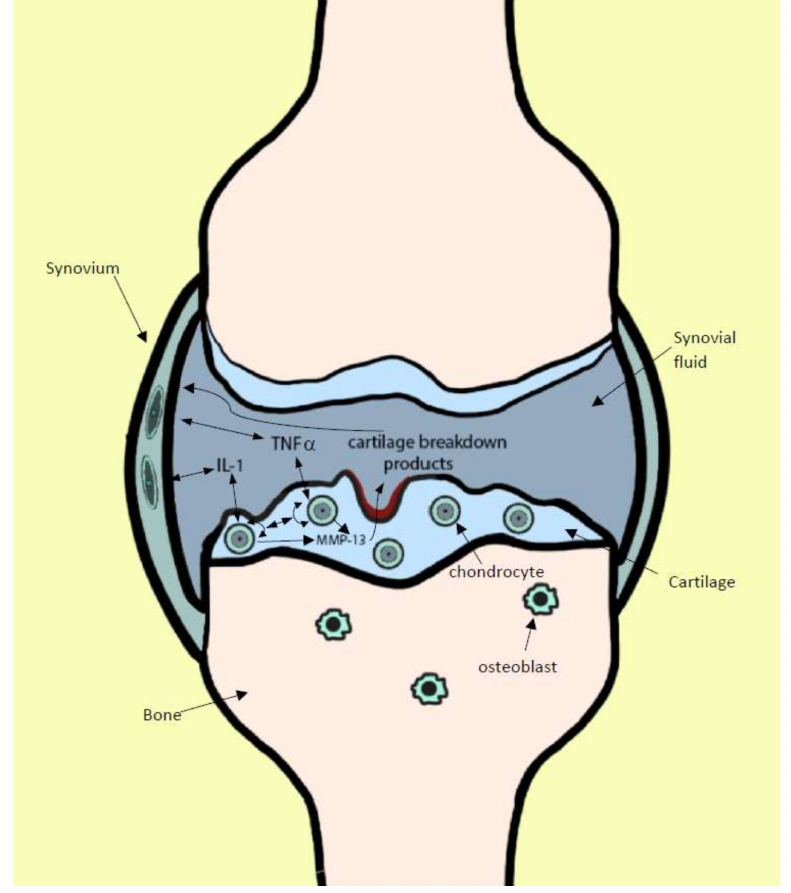
Figure 1. Model of feed-forward loop of pro-inflammatory cytokine-driven OA progression. IL-1 β and TNF α bind to chondrocytes and induce expression of MMP-13. MMP-13 causes cartilage matrix breakdown. Cartilage breakdown products inflame cells in the synovium, inducing more production of IL-1 β and TNF α